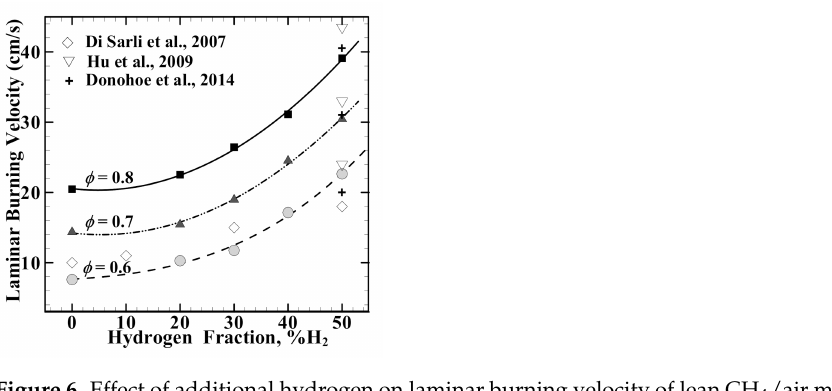
Figure 6. Effect of additional hydrogen on laminar burning velocity of lean CH 4 /air mixtures at three equivalence ratios ( φ = 0.6, 0.7, and 0.8). The solid symbols are experimental data, and the curves are their fitting